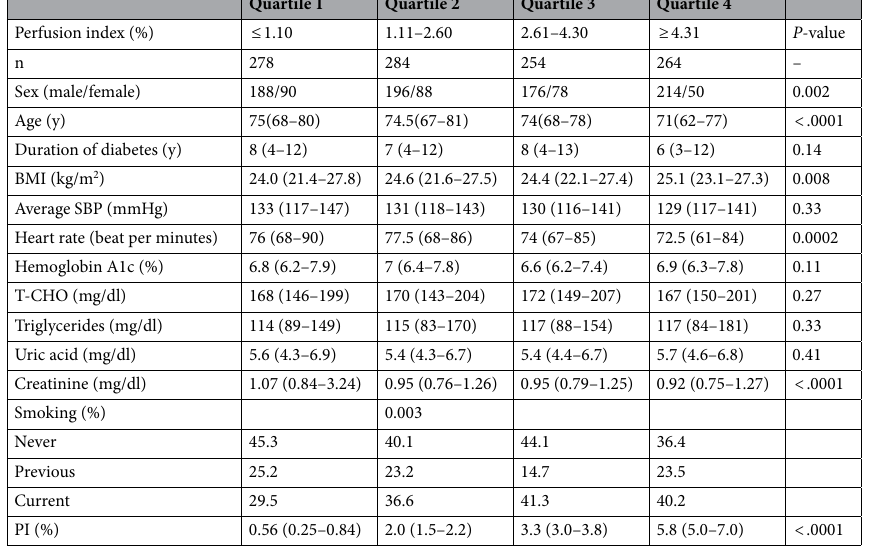
Table 2. Characteristics at baseline according to quartiles of perfusion index. Data are expressed as the median (interquartile range) or absolute number. BMI, body mass index; SBP, systolic blood pressure; T-CHO, total cholesterol. P values are from chi-square tests (for categorical data) or from ANOVA (for continuous data).